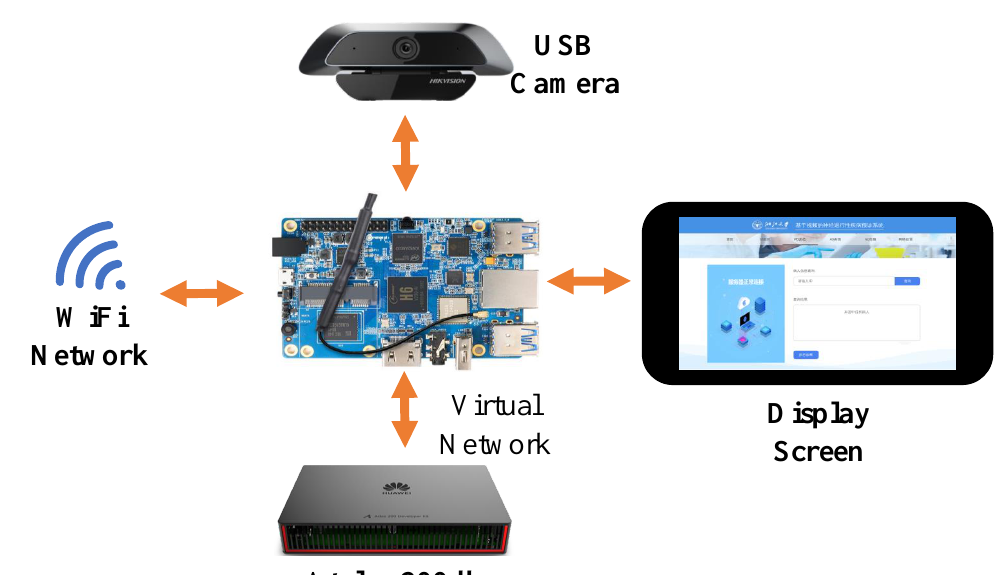
Figure 5. The equipment structure. An additional development board is used to expand the necessary interface. All devices are integrated in a